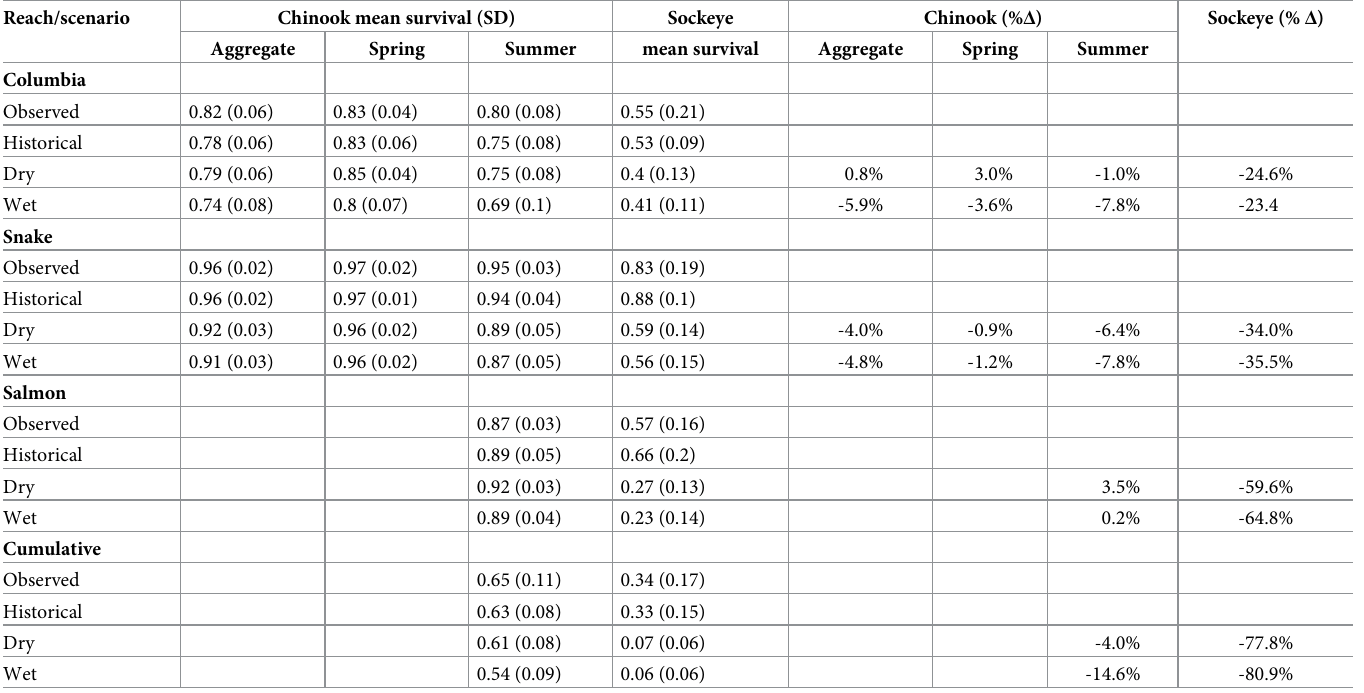
Table 4. Mean (SD) survival of Chinook and sockeye salmon under simulated climate scenarios vs. observed climate data. Reach/scenario Chinook mean survival (SD) Sockeye Chinook (% Δ ) Sockeye (% Δ ) Aggregate Spring Summer mean survival Aggregate Spring